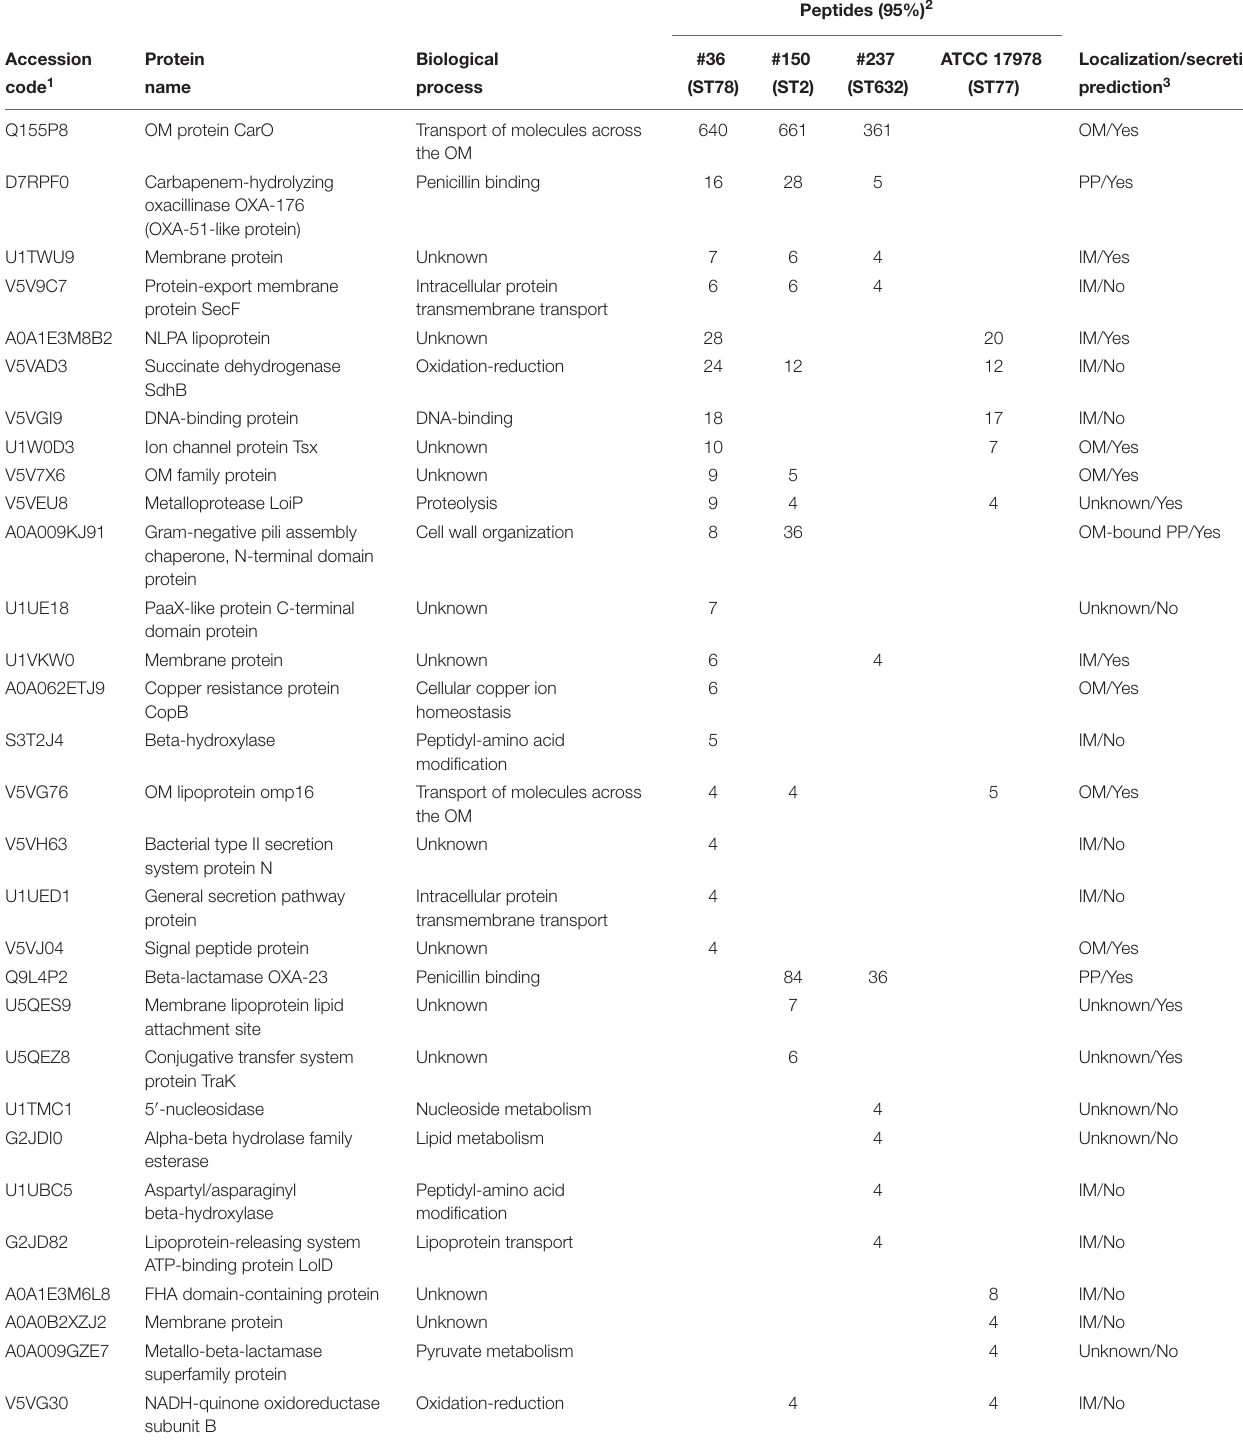
TABLE 1 | Identification of differentially expressed proteins from the OM fractions of carbapenem-resistant Acinetobacter baumannii (CRAb) and ATCC 17978 reference strain, matching criteria described in Section “Materials and Methods” and with a MW included in the range of 20–36